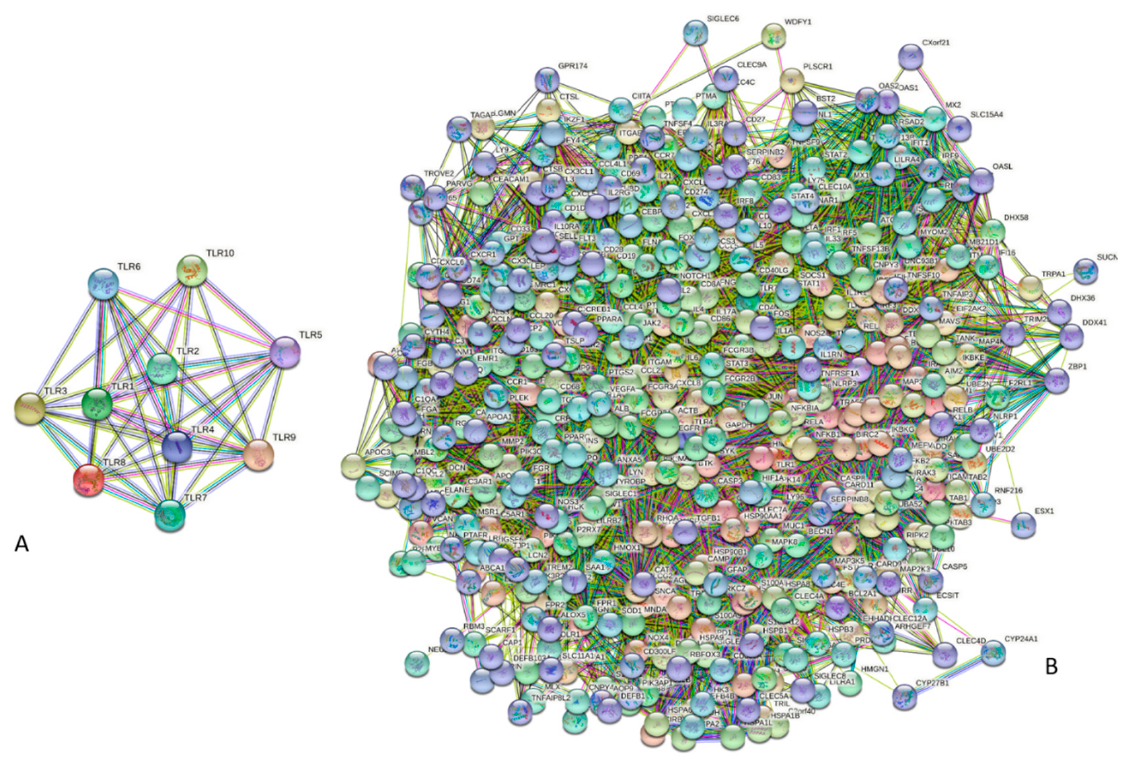
Figure 2. The internal ( A ) and external PPI networks ( B ) of human TLRs generated by STRING (Search Tool for the Retrieval of Interacting Genes, http://string-db.org/ accessed on July 7, 2022) designed to show the predicted and experimentally-validated interactions of a protein of interest [98] . In the internal network, TLRs are connected by 41 interactions, where each TLR, on average, interacts with eight partners. In the external PPI network, 10 TLRs interact with 449 partners, which are connected by 11,715 binary PPIs. The average node degree of these network is 51 (i.e., each member of this network is expected to interact with 51 partners). Amino acid sequences of the HCV polyprotein genotype 1a (isolate H77), mature individual HCV proteins, human TLRs, and 41 major players of TLR-triggered downstream pathways were retrieved from UniProt (https://www.uniprot.org/ accessed on July 7, 2022) [99] . Corresponding information is included in the Supplementary Figure S1. Search Tool for the Retrieval of Interacting Genes; STRING, http://string-db.org/ accessed on July 7, 2022 [98] , was used to obtain information on the interactability of HCV proteins, human TLRs, and 41 major players of TLR-triggered downstream pathways. The STRING output represents a network of predicted and experimentally-validated protein–protein interactions using seven types of evidence such as co-expression evidence (black line), co-occurrence evidence (blue line), neighborhood evidence (green line), database evidence (light blue line), experimental evidence (purple line), fusion evidence (red line), and text mining evidence (yellow line) [98] . The protein–protein interaction networks of all query proteins are shown in the Supplementary Figure S1.